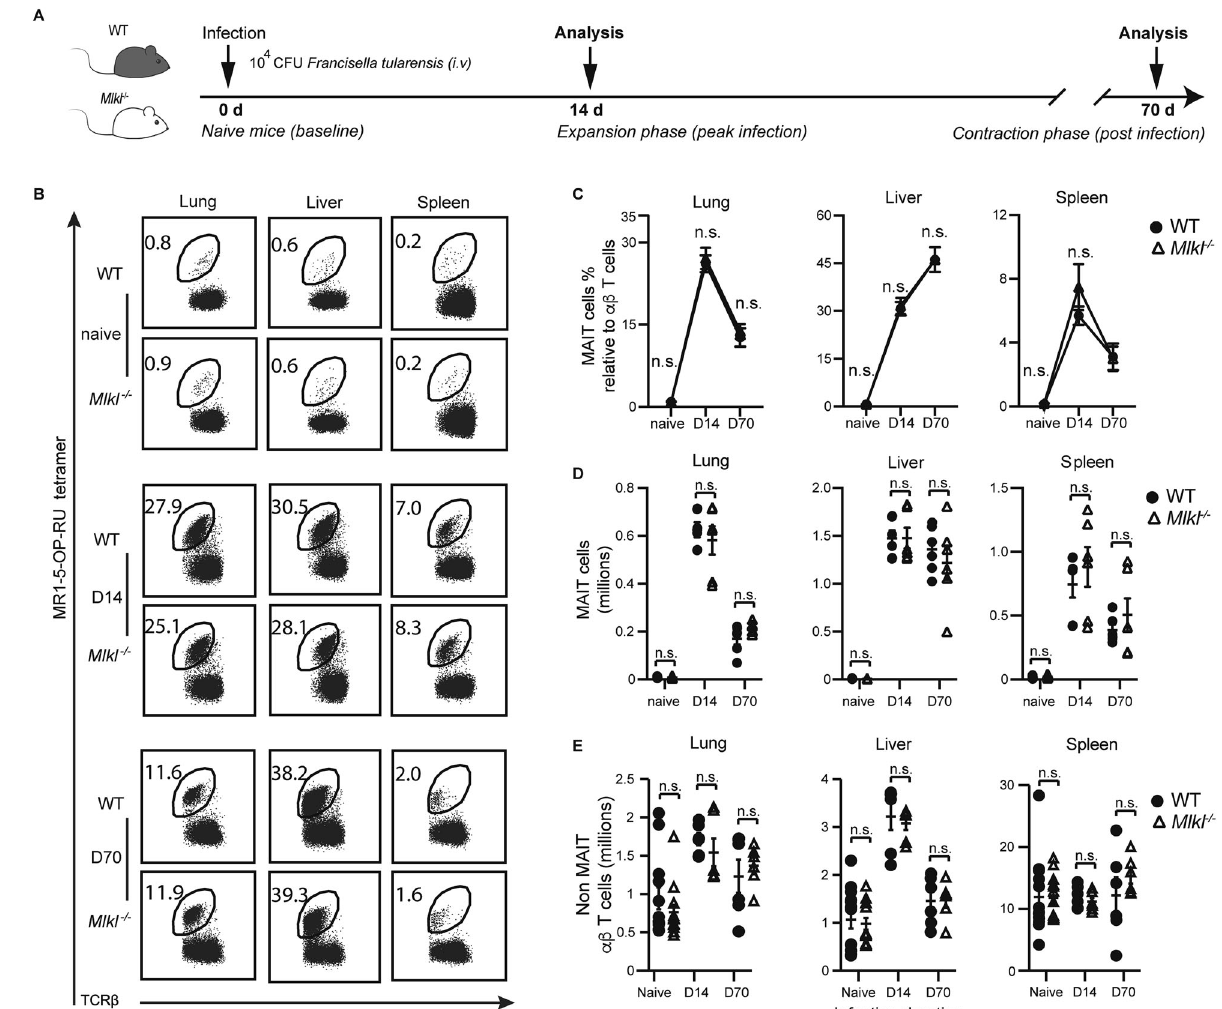
Fig. 4 Mlkl − / − mice have no increase in MAIT cell abundance during F. tularensis infection. A C57BL/6 (WT) and Mlkl − / − mice were either uninfected or infected with 10 4 CFU of F. tularensis LVS (i.v.) for 14 or 70 days. B Flow plots showing TCR β + lymphocytes in lungs, liver, and spleen from WT or Mlkl − / − , as indicated, with MAIT cells gated in naïve mice and at the indicated time points postinfection. MAIT cell abundance is expressed as a percentage of TCR β + lymphocytes. C Relative MAIT cell abundance (as in B ) in infected and naïve WT and Mlkl − / − mice at the indicated time points and in indicated tissues. D Absolute numbers of MAIT cells and E non-MAIT TCR β + lymphocytes in naïve and infected mice at the indicated time points and in the indicated tissues. C-E Error bars show the mean ± SEM of data pooled from 2 experiments (naïve mice n = 8; d14 infected n = 6; d70 infected n = 6). Statistical signi fi cance is indicated by ns ( p > 0.05); * ( p ≤ 0.05); * * ( p ≤ 0.01); or *** ( p ≤ 0.001) as determined by an unpaired two-tailed t -test with Welch ’ s correction for unequal